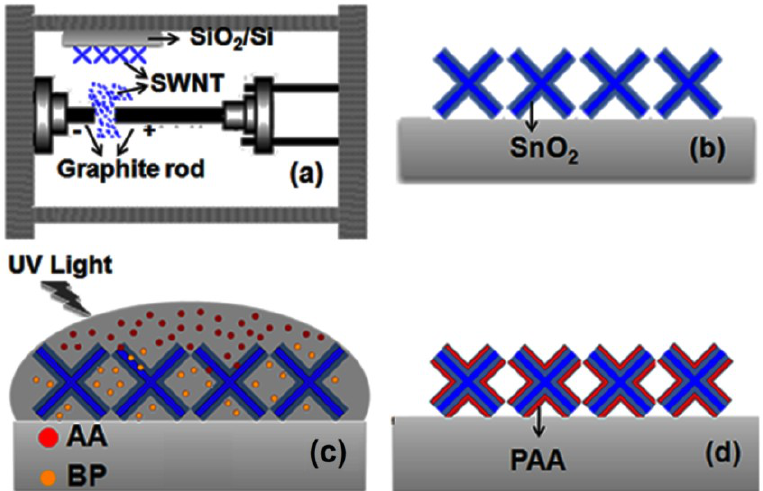
Figure 1. Schematic diagrams of the fabrication procedure for Poly(acrylic acid) (PAA)/SnO /single-walled carbon nanotubes (SWCNT) nanocomposites. ( a ) In situ deposition 2 of SWCNT; ( b ) structural diagram of SnO /SWCNT; ( c ) diagram of UV light-induced radical 2 polymerization of acrylic acid (AA) using benzophenone (BP) initiator; and ( d ) structural diagram of PAA/SnO /SWCNT 2